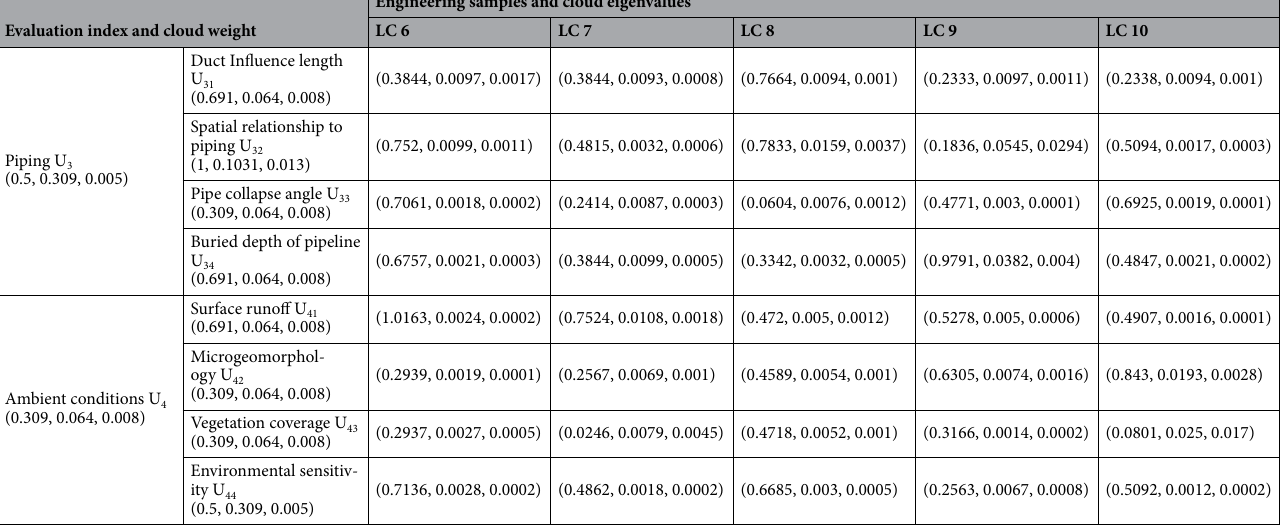
Table 6. Calculation results of cloud for each index level and